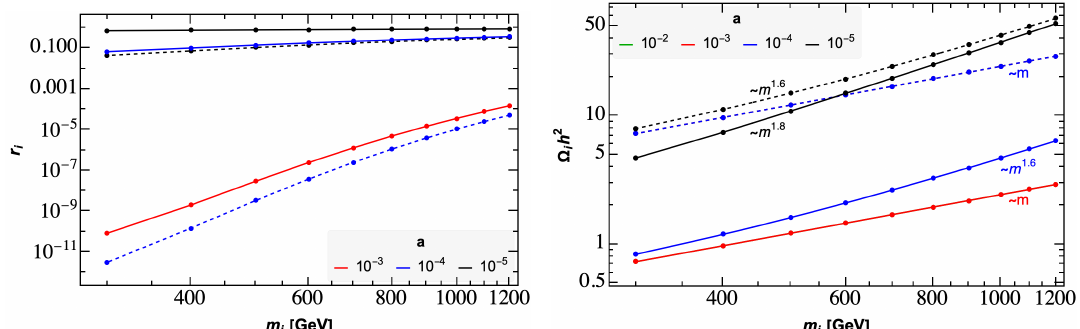
Figure 8 . Asymmetry ratio ( left panel ) and abundance ( right panel ) versus DM mass for different choices of a in the light mediator case , without conversions, for N = 10 . Left: notice that all the dashed curves ( (cid:15) = 1) are suppressed compared to the solid ( (cid:15) = 0 . 1 ) ones. The red dashed curve is highly suppressed and does not appear in the plot. Right: The green solid curve corresponding to a = 10 − 2 coincides exactly with the red solid curve, whereas the dashed green and red curves coincide exactly with the blue dashed